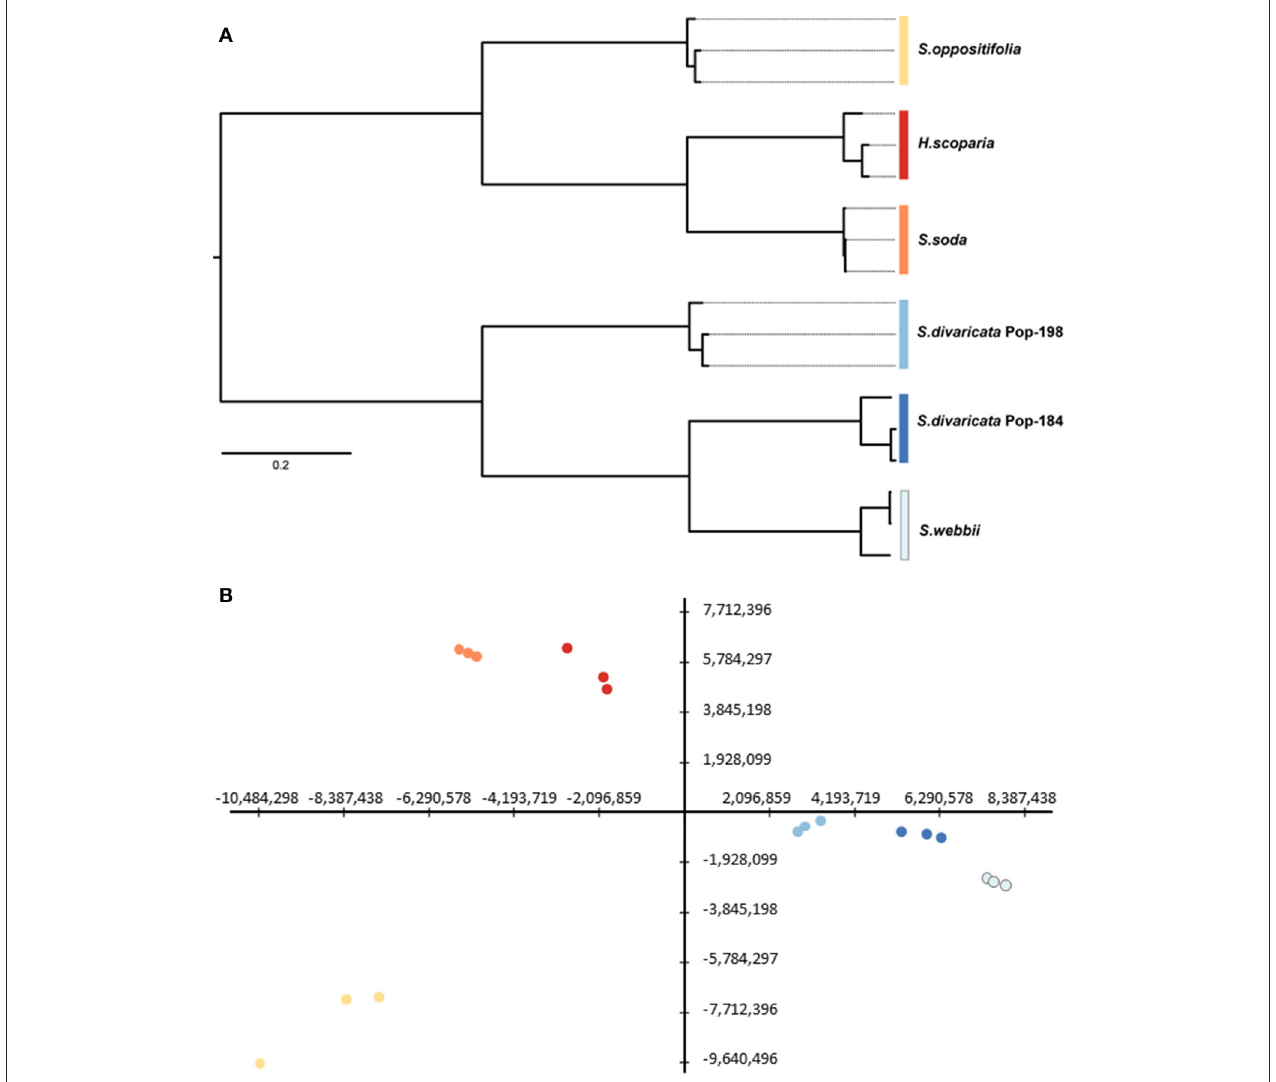
FIGURE 2 | (A) Hierarchical clustering using Pearson correlation and (B) principal component analysis showing the first (X-axis) and second (Y-axis) components, which explain 57.41% of the total variation (see Supplementary Figure S5 for the first three components), of gene expression data. (The colors in B ) are the same as in (A) and corresponds to replicates of the respective species).